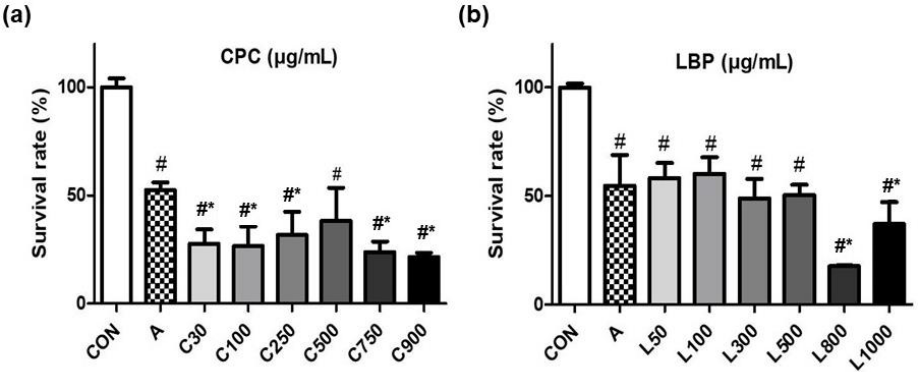
Figure 1. Effects of ( a ) C-phycocyanin (CPC) or ( b ) Lycium barbarum polysaccharides (LBP) on the